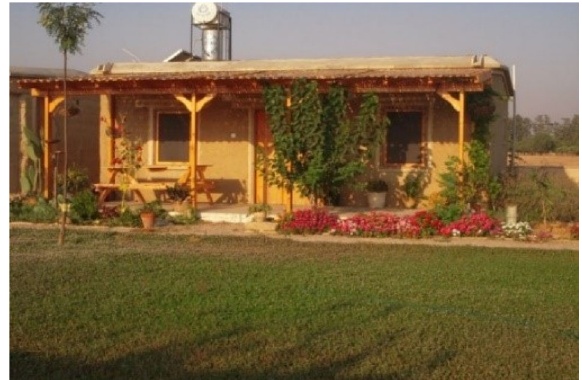
Fig. 10 Erson Hoca ’ s Organic Farm Hotel — Limnitis. Example of reinforced concrete construction.